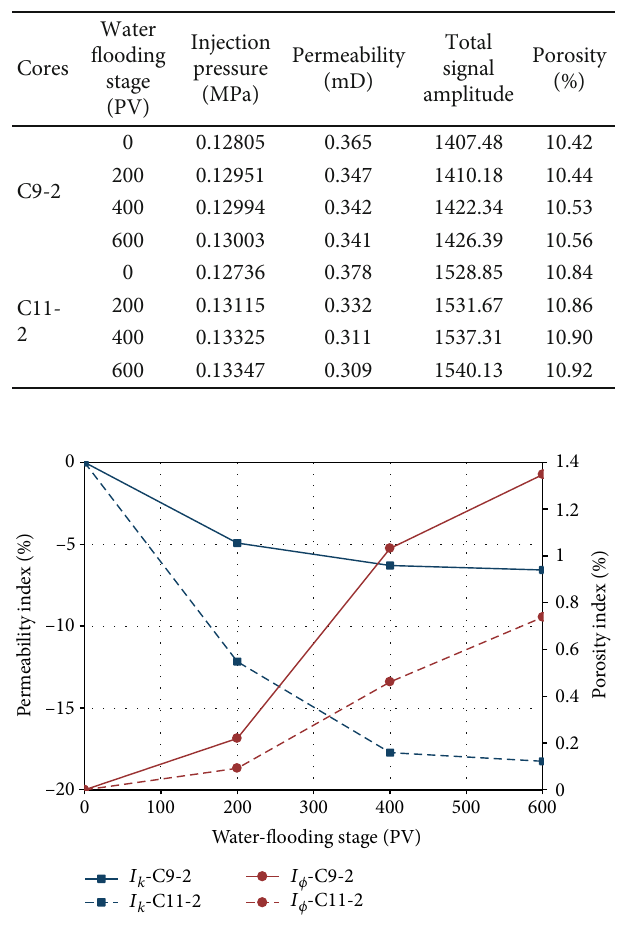
Figure 3: Permeability index and porosity index during the LTWF.